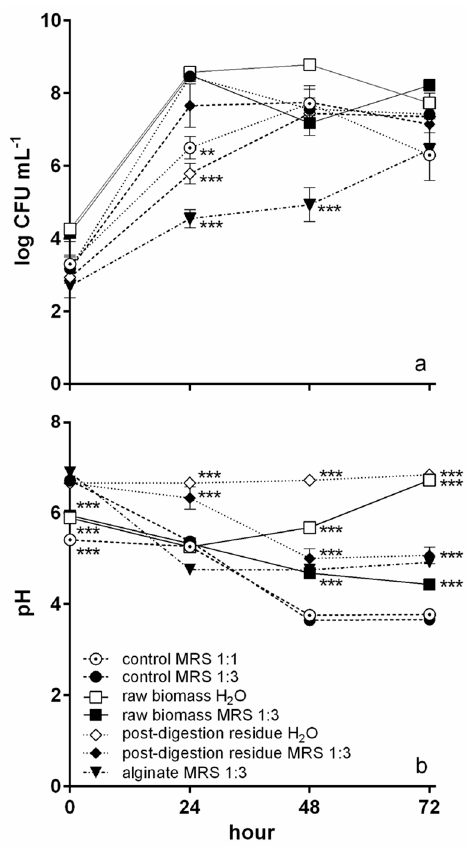
Figure 4. Fermentation trial. ( a ) L. plantarum ATCC 8014 growth curves and ( b ) pH variation during fermentation in the controls (MRS 1:1, MRS 1:3), in the positive control (alginate in MRS 1:3), and in cultures with T. lutea F&M-M36 raw biomass and post-digestion residue in the two matrixes (H 2 O and MRS 1:3). Data are expressed as mean ± standard error. ** significant difference ( p < 0.01); *** highly significant difference ( p < 0.001) compared to values of MRS 1:3 control.